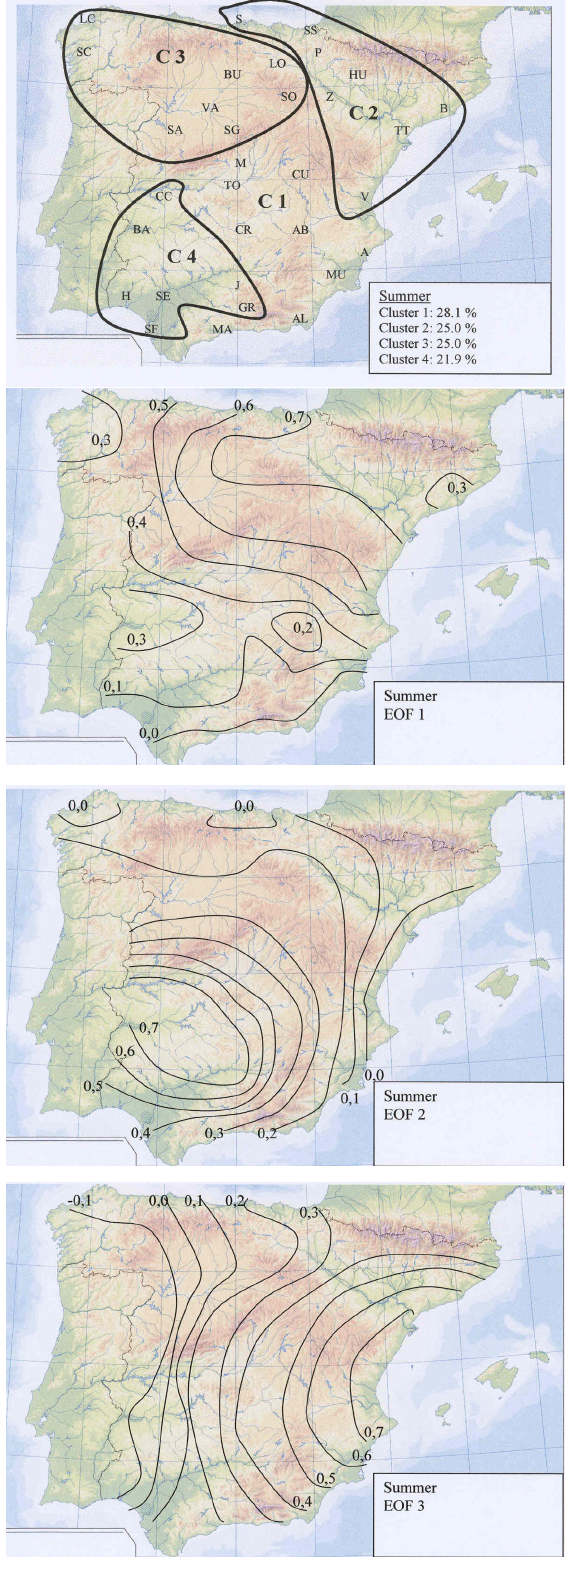
Fig. 8. As Fig. 6, for